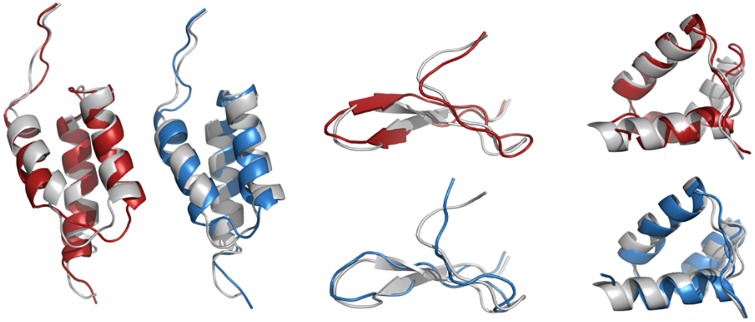
Best models obtained with the simulations with the mixed libraries.Models obtained with PSI libraries (blue) and BLO libraries (red) are superposed to the experimental structure (white). PDB(RMSD BLO, RMSD PSI): 1BDD (1.38,1.65); 1E0N (1.37,1.65), 1ENH (1.31,1.39).